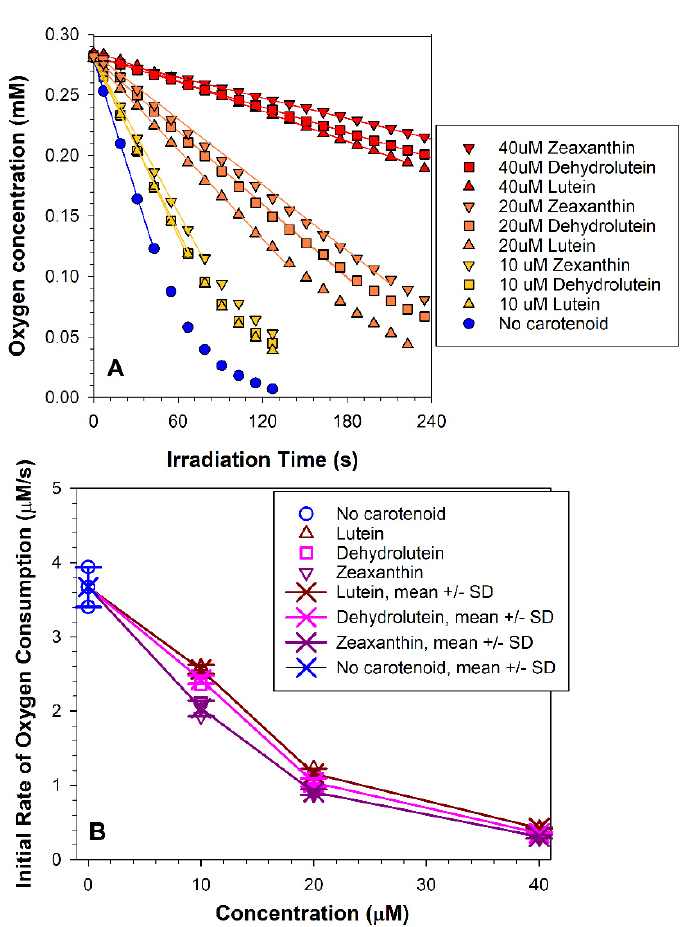
Figure 4. Dehydrolutein inhibits all- trans -retinal-mediated photo-oxidation with similar effi- ciency to lutein and zeaxanthin . ( A ) Representative kinetics of oxygen consumption during expo- sure of liposomes to all- trans -retinal and blue light in the absence and presence of carotenoids at indicated concentrations. Liposomes, consisting of 2.5 mg/mL EYPC, 0.75 mM all- trans -retinal, and indicated concentration of carotenoids, were exposed to blue light (404 ± 6 nm, 8.1 mW/cm 2 ) in the presence of 1% DMSO. The samples included 0.1 mM mHCTPO used as a spin probe. The initial linear portions of the kinetics were fitted to straight lines, and the slopes of these lines gave the initial rates of oxygen consumption. ( B ) The initial rates of oxygen consumption in the absence and presence of indicated carotenoids as a function of carotenoid concentration. Statistically significant differences between the initial rates of oxygen consumption were observed between the carotenoid at 10 µM concentrations only. Oxidation in the presence of 10 µM zeaxanthin was significantly slower than for 10 µM dehydrolutein or lutein ( p < 0.001, in both cases).